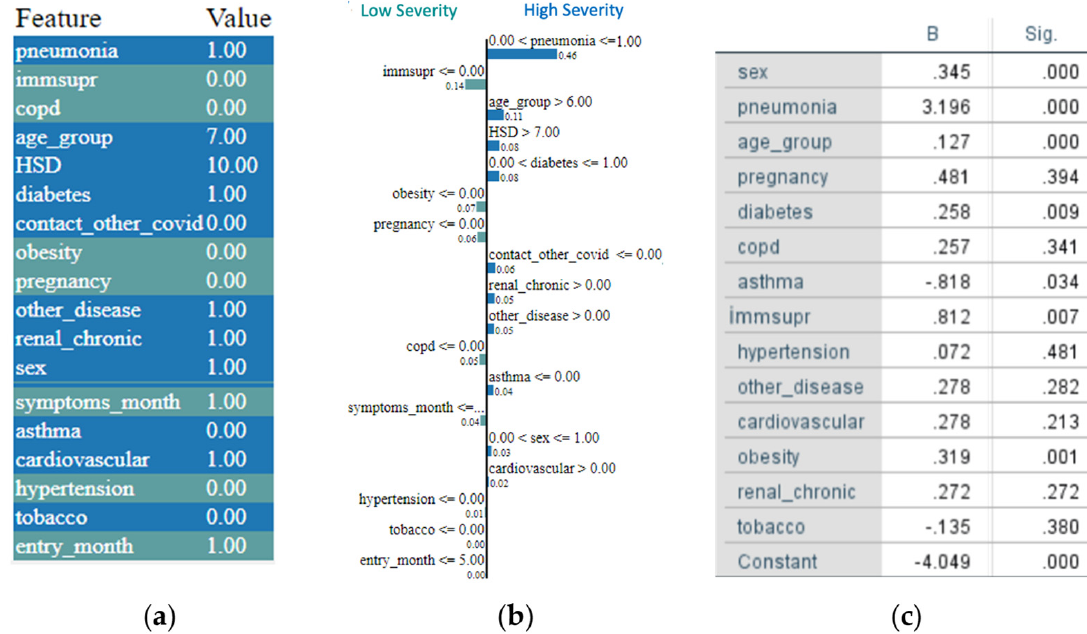
Figure 4. Example of a patient diagnosed with COVID-19: ( a ) patient’s medical history, ( b ) explanation of the prediction, and ( c ) binary regression variables in equation.